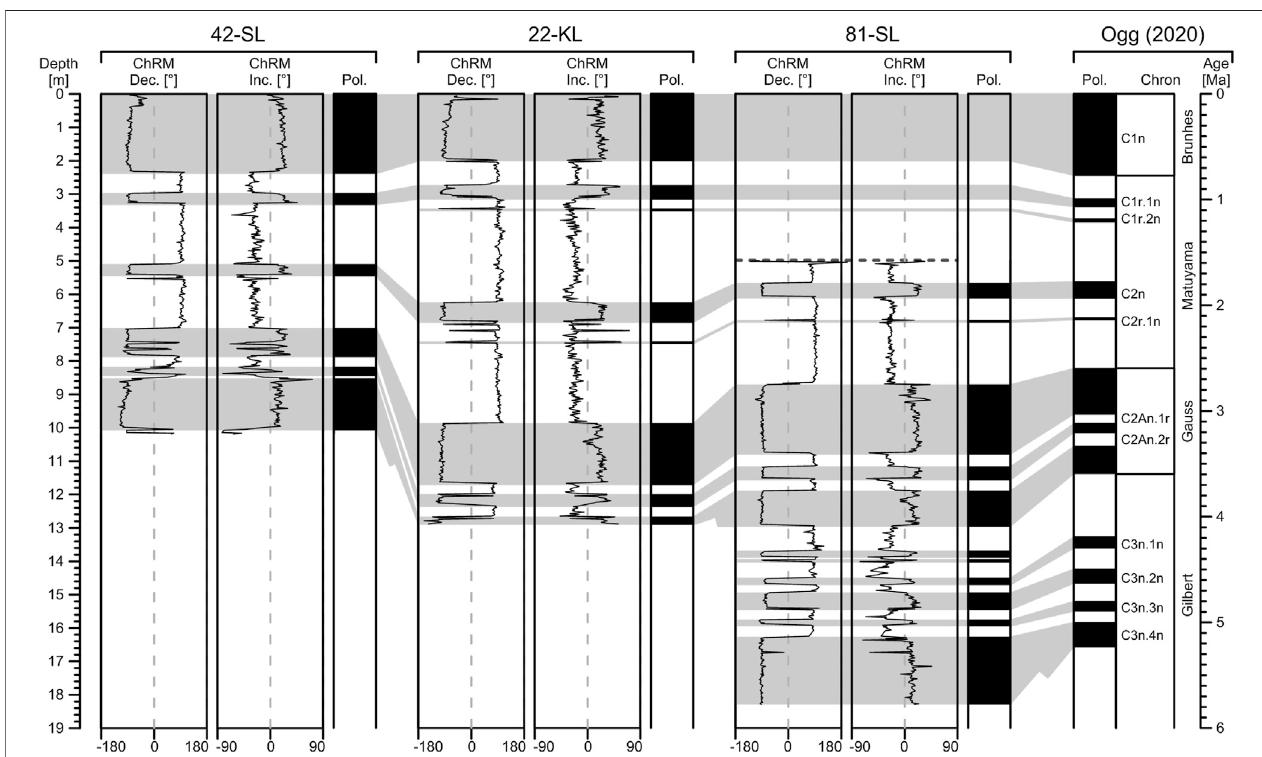
FIGURE 5 | Down core plots of ChRM data and corresponding polarity pattern at the three coring sites alongside with the polarity reference from Ogg (2020). The topmost layers of core 81-SL are missing. For improved presentability, the data of core 81-SL was shifted downwards by 5.2 m and consequently the depth indication needs to be converted in case of core 81-SL. Areas shaded in gray display the correlatable periods of normal ChRM polarization.